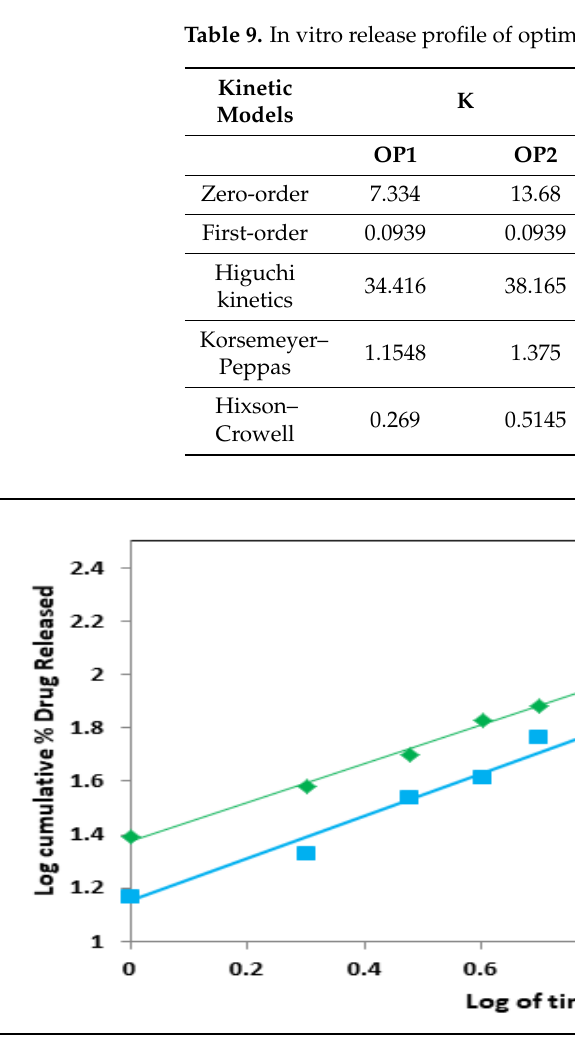
Figure 9. Korsemeyer – Peppas plot of the optimized formulation (OP1 and OP2).